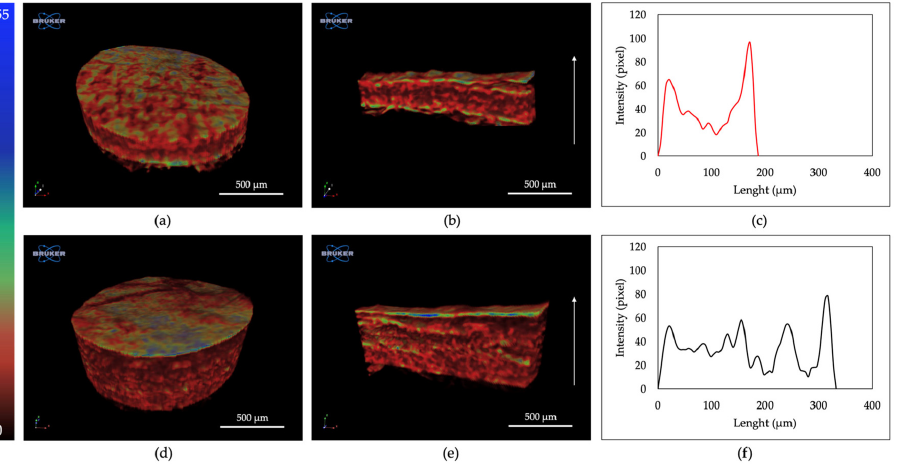
Figure 3. Three-dimensional rendering reconstruction of mCT scans of ST ( a ) and BT ( d ), their coronal section ( b , e , respectively) in colored scale, and their relative intensity profile ( c , f ,